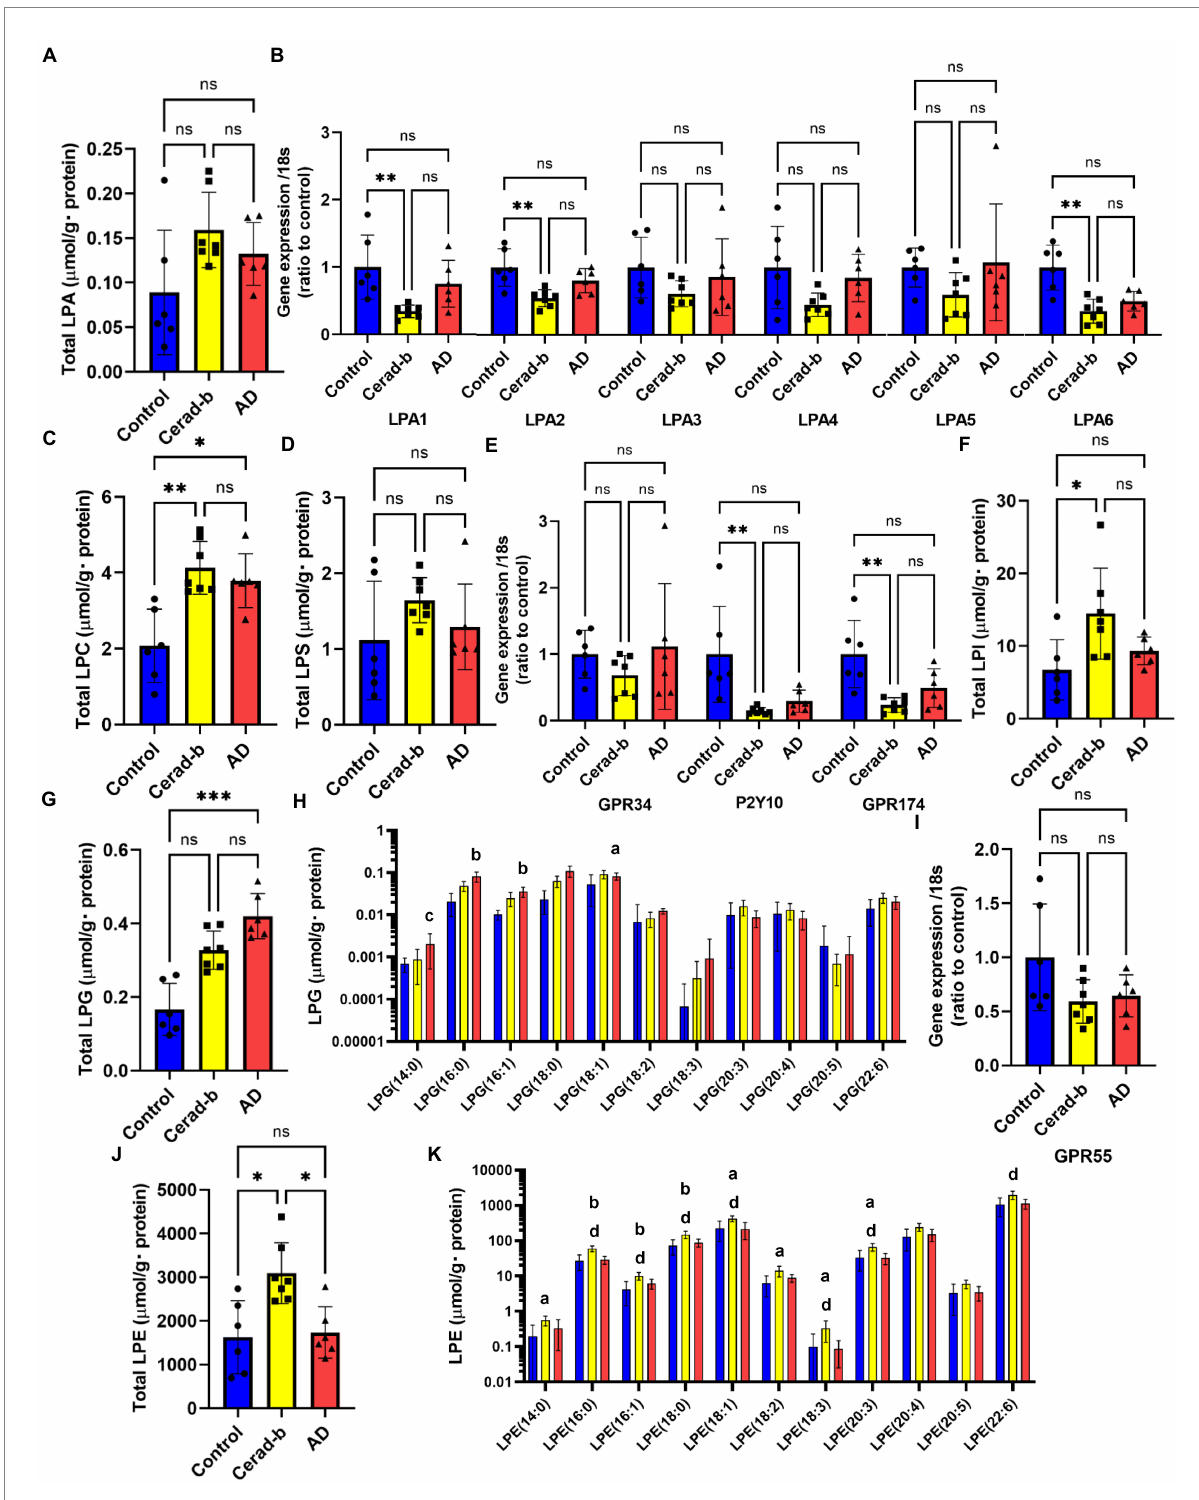
FIGURE 2 Modulations of the glycero-lysophospholipid levels and mRNA expression levels of LPA, LPS, and LPI/LPG receptors in the brain in AD and Cerad-b. The glycero-lysophospholipid levels and mRNA expression levels of LPA, LPS, and LPI/LPG receptors were measured in the brains of control subjects ( n = 6), patients with Cerad-b ( n = 7), and patients with AD ( n = 6). The Kruskal-Wallis test, followed by the Steel-Dwass test as a post-hoc test, was used for statistical evaluation of the differences. (A) Total LPA levels. (B) The mRNA levels of the LPA receptors adjusted to the expression level of 18 s as the internal standard. (C) Total LPC levels. (D) Total LPS levels. (E) mRNA expression levels of LPS receptors adjusted to the expression level of 18 s as the internal standard. (F) Total LPI levels. (G) Total LPG levels. (H) LPG species. (I) mRNA levels of the LPI/LPG receptor, GPR55, adjusted to the expression level of 18 s as the internal standard. (J) Total LPE levels. (K) LPE species. * p < 0.05; ** p < 0.01; *** p < 0.001; ns, not significant; a, p < 0.05 vs. control; b, p < 0.01 vs. control; c, p < 0.001 vs. control; d, p < 0.05 between Cerad-b and AD; e, p < 0.01 between Cerad-b and AD; f, p < 0.001 between Cerad-b and